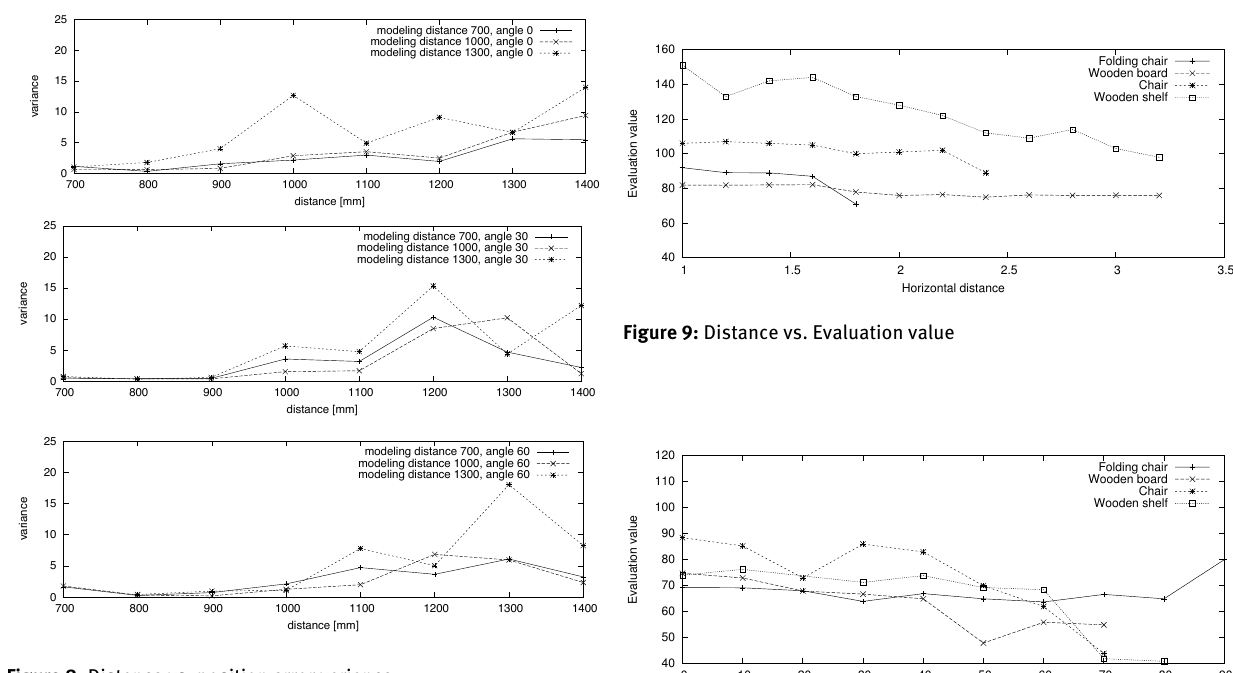
Figure 8: Distance vs. position error variance – The detection range of the folding chair was short be- cause the chair has comparatively reflective surfaces, and the inclination of the surfaces against the optic axis was large. In this case, the original sensor data lacked depth information.